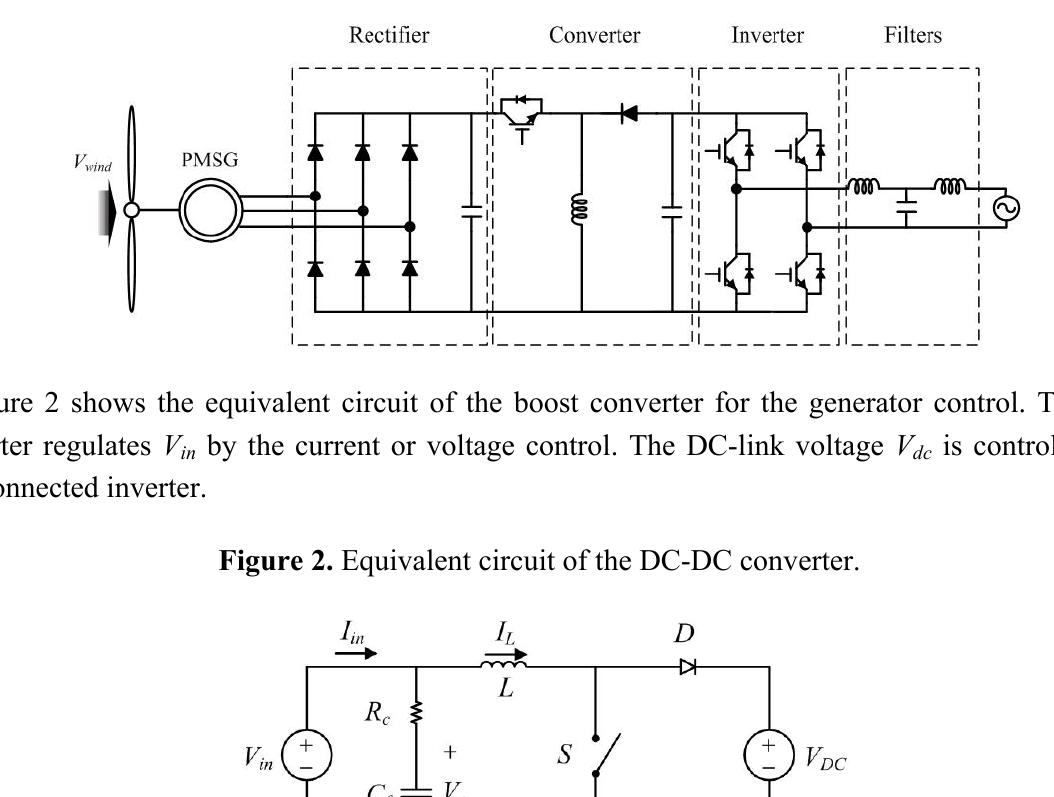
Figure 1. Gird-connected wind power systems.